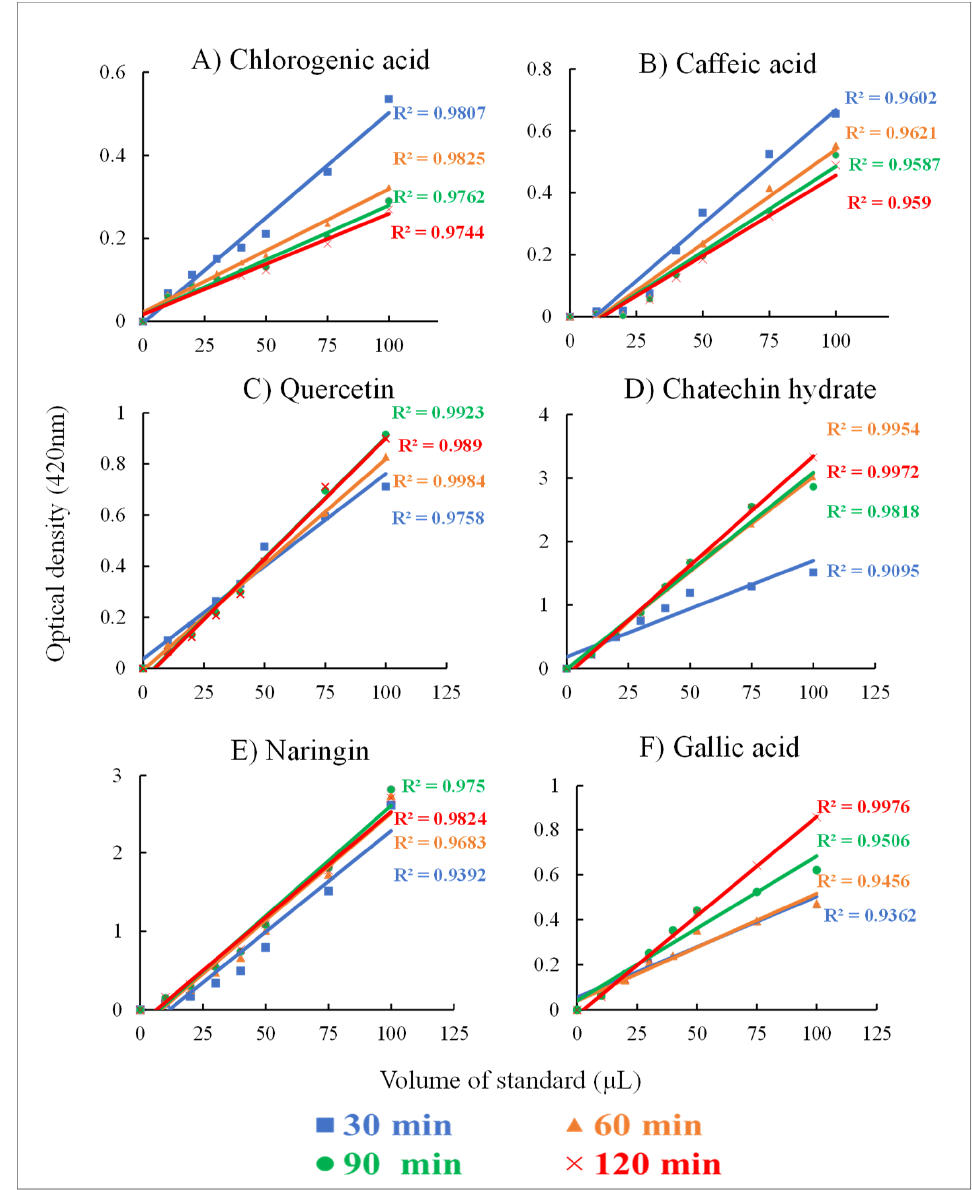
Figure 2. Reaction rate and incubation times evaluated using the optimized FB assay on standards. Linear regression lines were plotted to obtain R 2 at four-time points. Phenolic standards: ( A ) chlorogenic acid, ( B ) caffeic acid, ( C ) quercetin, ( D ) catechin hydrate, ( E ) naringenin, and ( F ) gallic acid. Absorbance was read at 420 nm with kinetic readings. All standards concentrations were 250 µg mL − 1 and alkali medium KOH (1 N) and 0.01% FB assay solution was used for the assay.